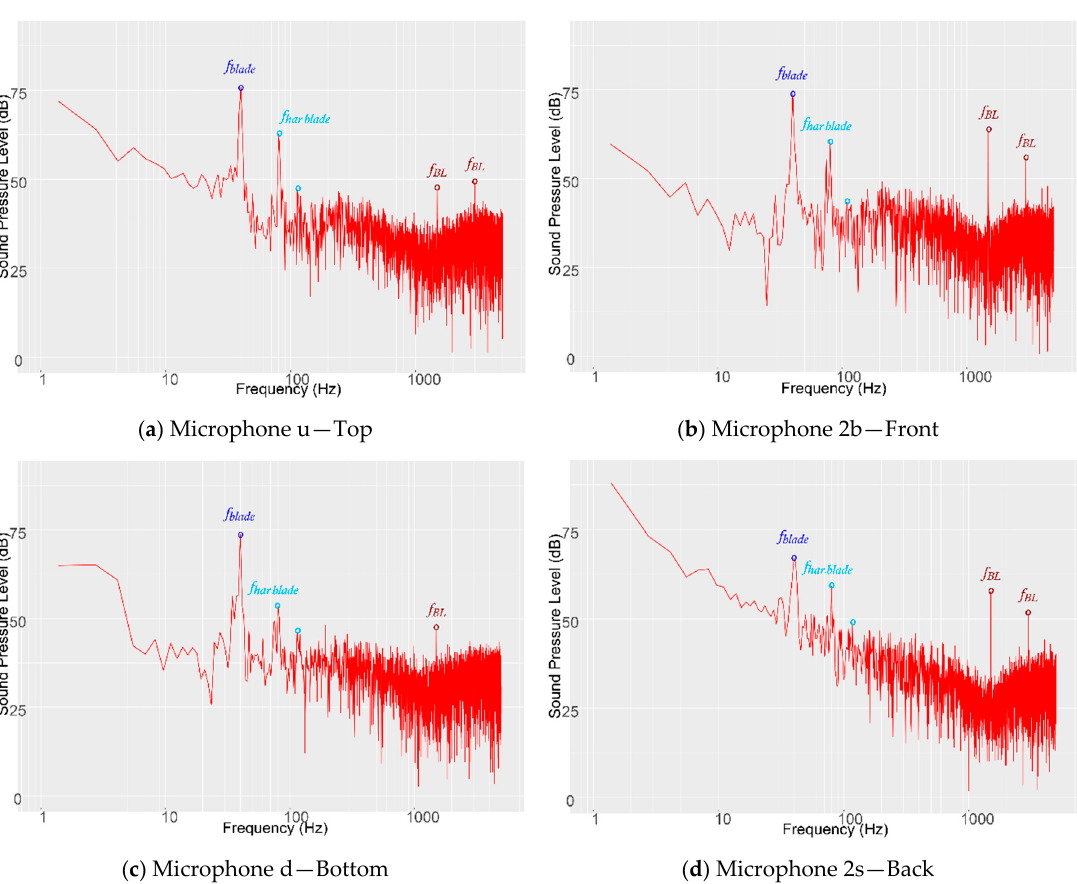
Figure 8. Sound Pressure Level at various microphone locations (shown in Figure 9a) for the group of VAWTs in close proximity: ( a ) Microphone u—Top, ( b ) Microphone 2b—Front, ( c ) Microphone d—Bottom and ( d ) Microphone 2s—Back.